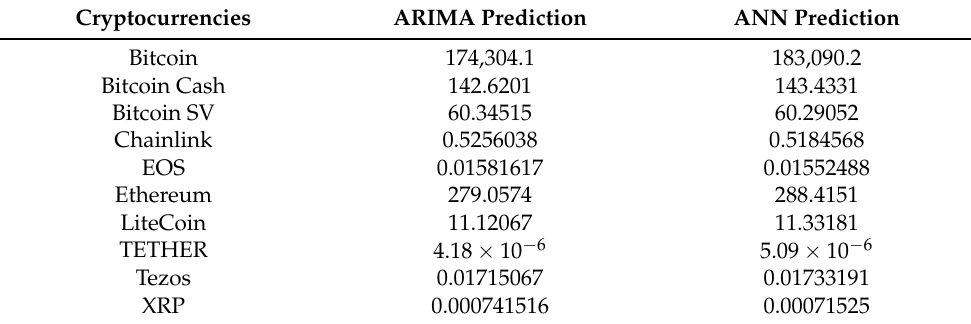
Table 6. Mean square error.